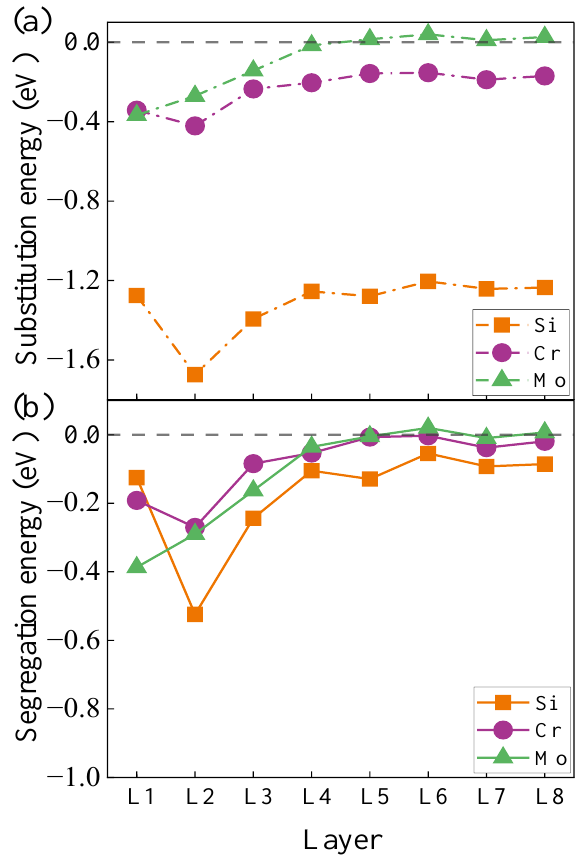
Figure 2. ( a ) Substitution energy and ( b ) segregation energy of alloying atoms in different layers of the pure Fe-GB. Si, Mo and Cr are represented by yellow squares, purple circles and green triangles, respectively.